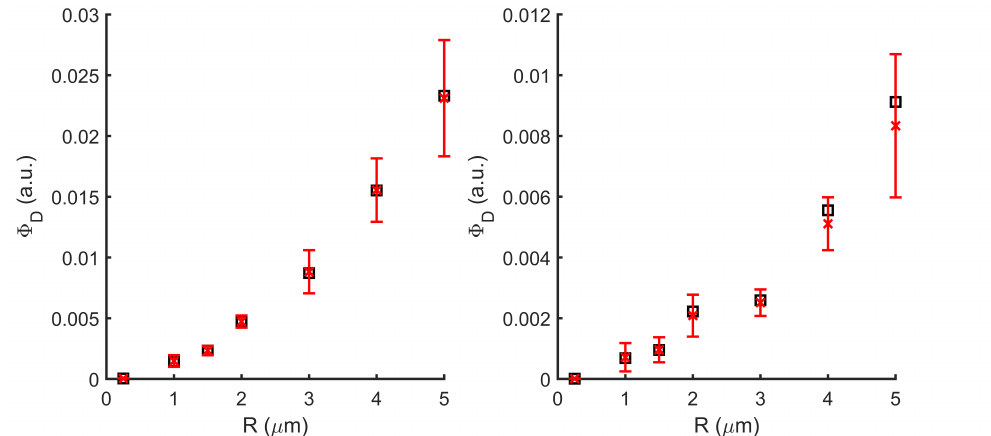
Figure 6. Detector intensity comparison between the Monte Carlo (red bar error) and W f (black squares) methods for different particle radius. Left : forward, right :